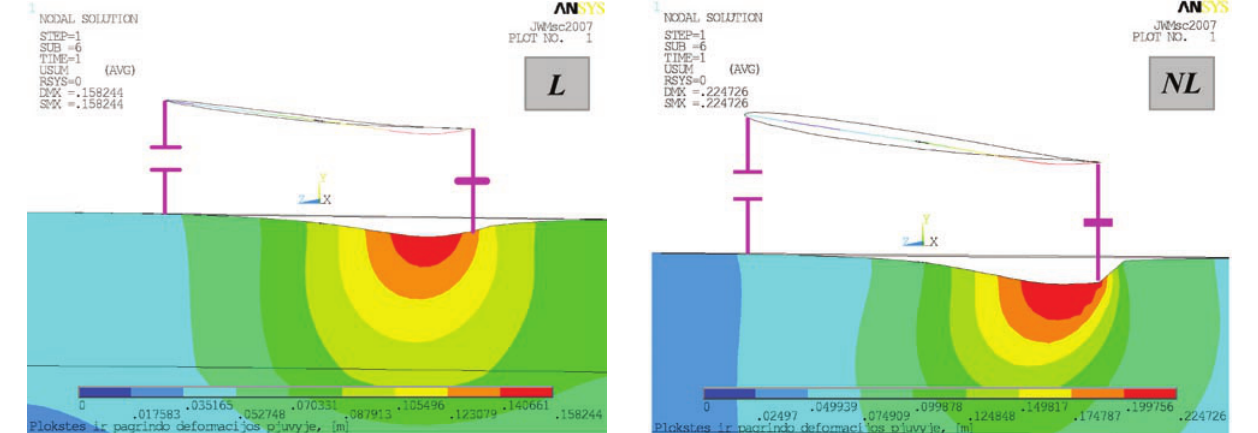
Fig. 10. Stress intensity contours according to von Mises in the section (linear analysis), Pa